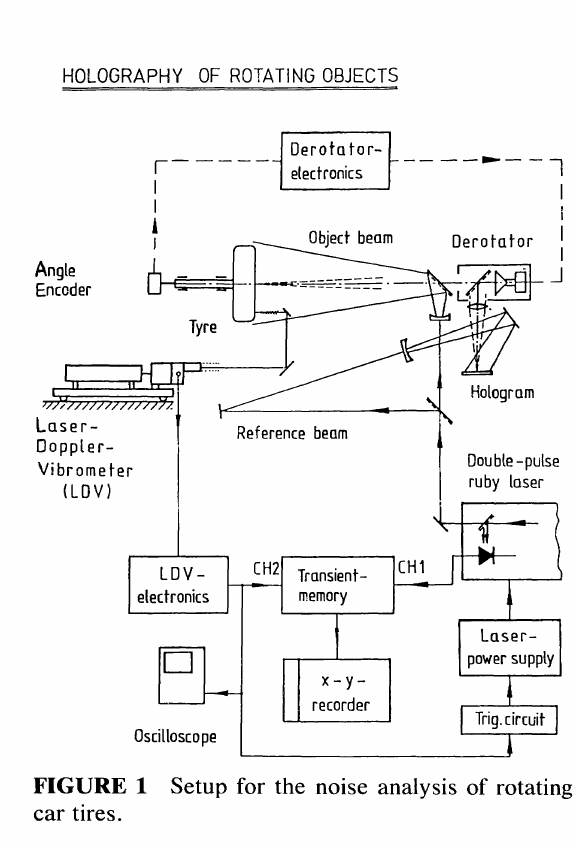
FIGURE 1 Setup for the noise analysis of rotating car tires.